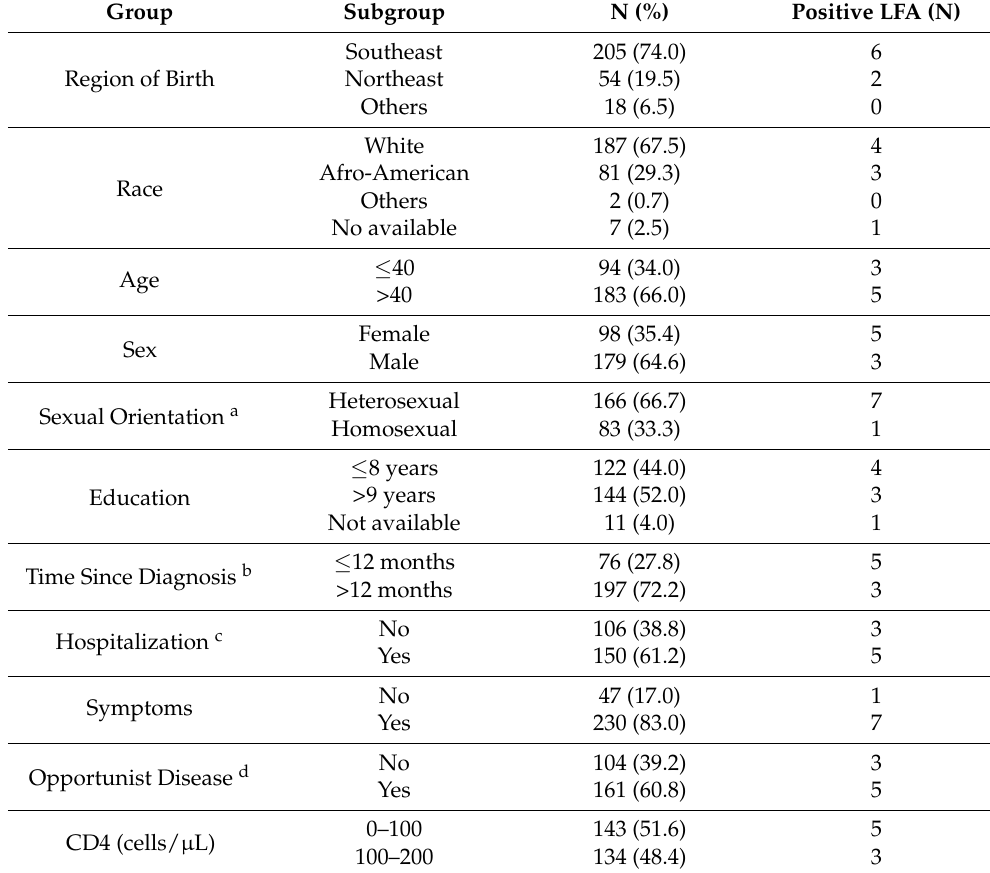
Table 2. Distribution of patients according to frequencies of positive lateral flow assays and sociode- mographic, clinical, and laboratory